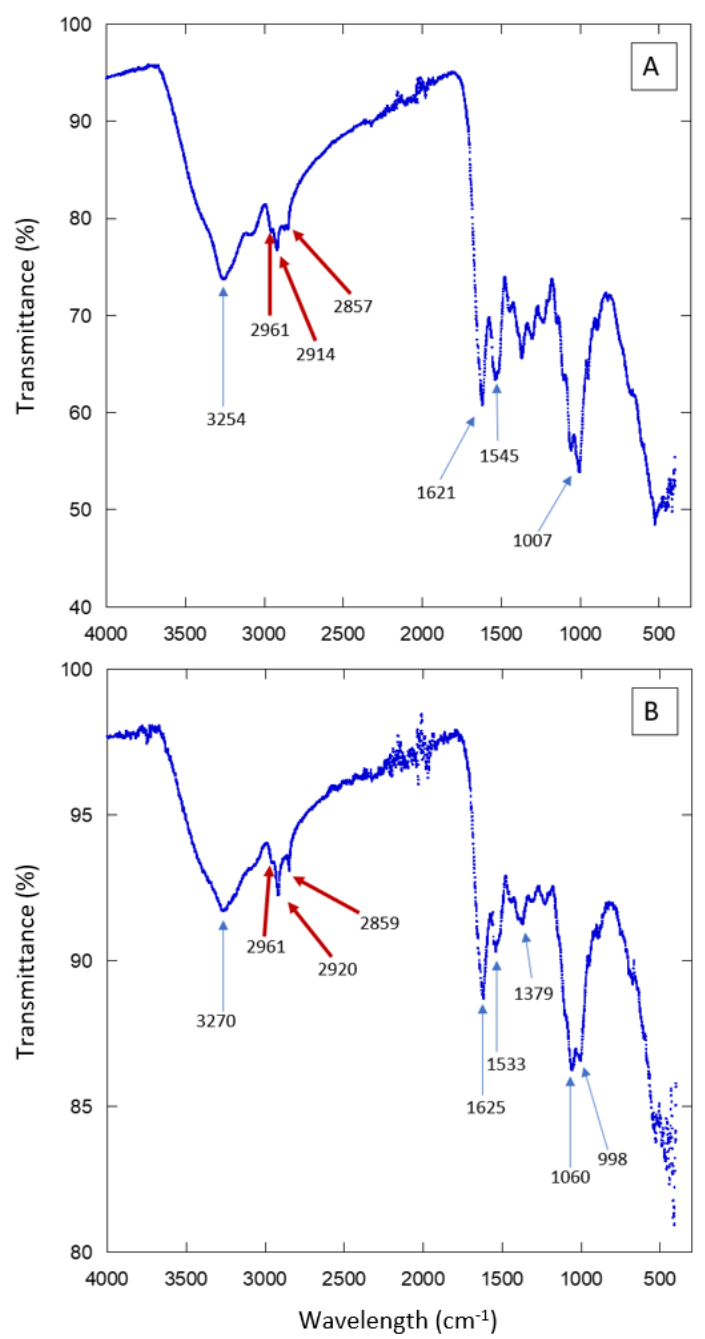
Figure 7. FT-IR scans of elytra from individuals collected in HMO ( A ) and KB ( B ).